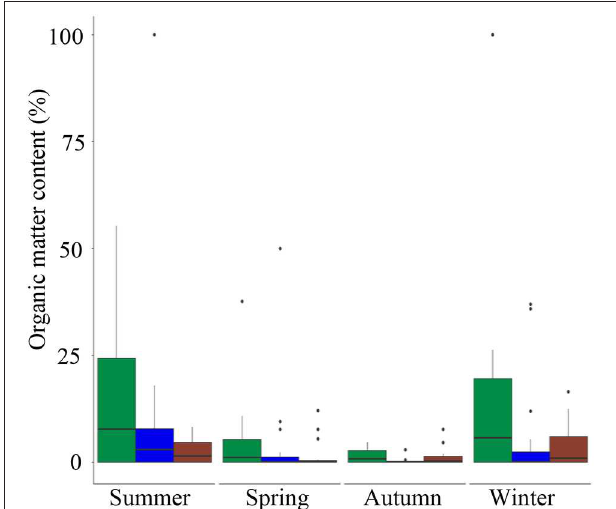
FIGURE 5 | Percentage organic matter content measured in each area for each season. Colors represent natural area (green), restored area (blue) and the mudflat (brown). Boxes show inter-quartile range (IQR), horizontal line is the mean and whiskers extend to largest observation less than or equal to 1.5 * IQR beyond box limit.